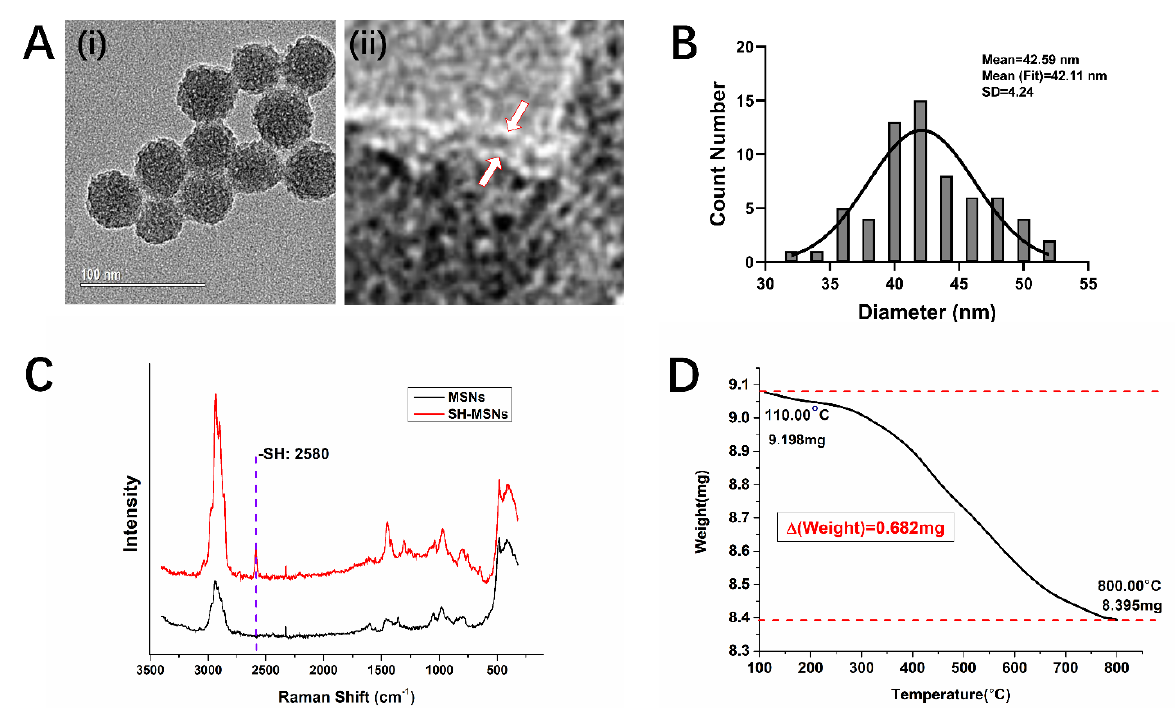
Figure 2. Characterization of synthesized SH-MSNPs and thiol bonds on the particle surface. ( A ) TEM images of (i) synthesized 50 nm SH-MSNPs, (ii) enlarged surface thiol bond layer of SH-MSNPs (layer indicated by arrows). ( B ) Gaussian distribution of SH-MSNPs diameter measured from the TEM images. ( C ) Thiol bond was detected using Raman Spectroscopy. A unique 2580 cm − 1 peak was shown in SH-MSNPs, but not in MSNPs. ( D ) The amount of functionalized thiol bond was quantified using TGA from 110 °C to 800 °C in nitrogen environment.